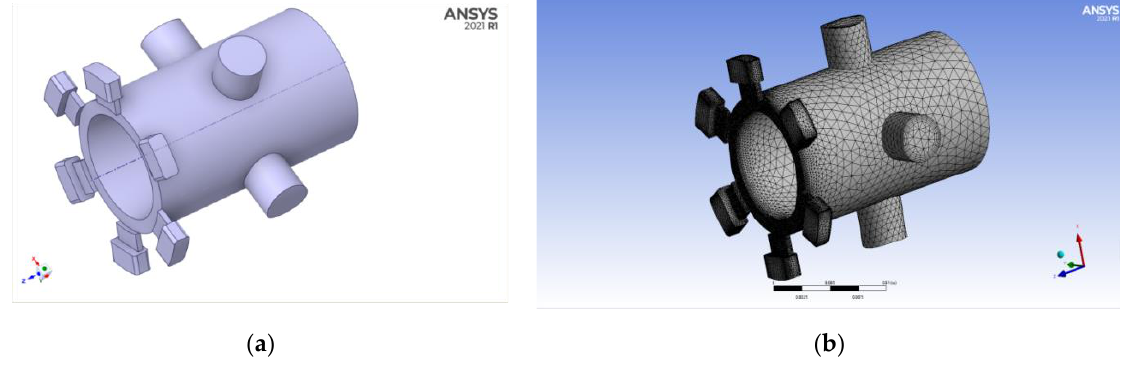
Figure 5. Simulated flow field model of spool valve sleeve: ( a ) Spool valve sleeve flow field model; ( b ) Flow field meshing model.